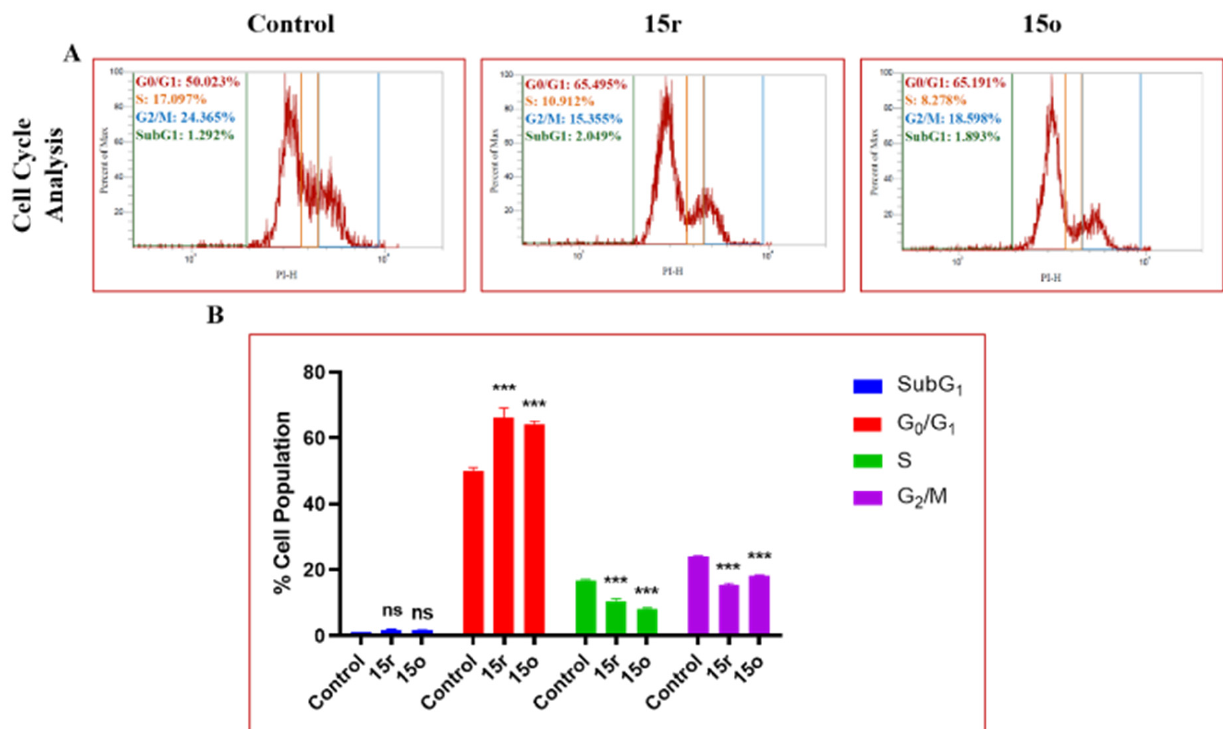
Figure 4. ( A ) Treatment with 15o (2 μ M) and 15r (1 μ M) in HT-29 cells showed significant G 0 /G 1 phase arrest as indicated by the increase in G 0 /G 1 phase cell population. ( B ) Bar graphs depict SubG 1 , G 0 /G 1 , S, and G 2 /M cell populations. Statistical significance was determined by two-way ANOVA followed by Tukey’s post-hoc analysis, where *** p < 0.001 represents control vs. 1,2,4-triazolo-linked bis -indolyl ( 15o and 15r ) conjugates in treatment groups and ‘ns’ represents not statistically significant in comparison to